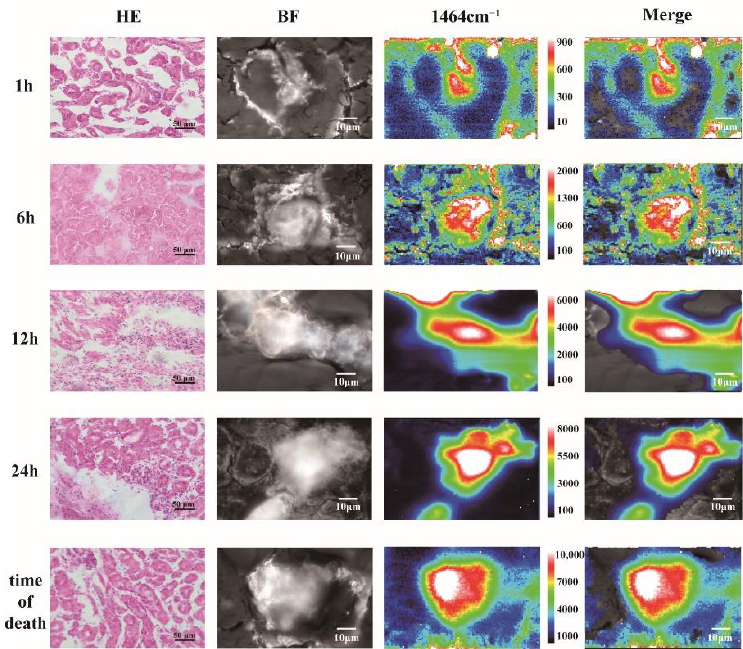
Figure 4. Multiple distributions of crystals with irregular shape in renal tubules of mouse (HE, 400×) and Raman mapping of calcium oxalate dihydrate crystals in the fresh biopsy specimens (magnification 1000×) at different time points (1 h, 6 h, 12 h, 24 h and time of death).